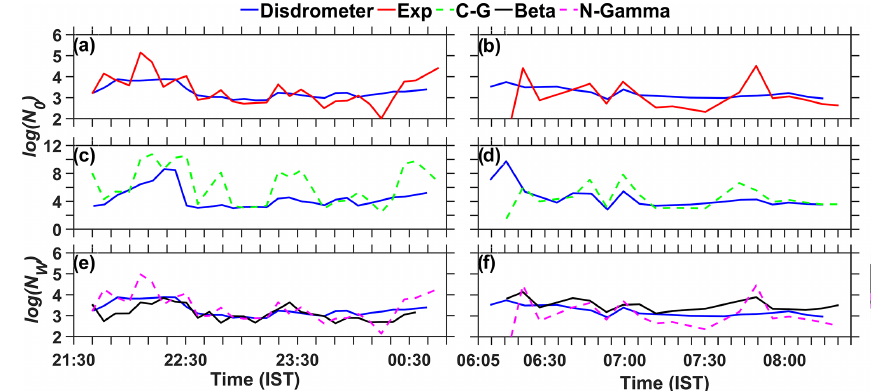
Figure 8. Comparison of log N 0 (a, b) by assuming an exponential distribution and (c, d) by assuming gamma distributions on 12 September 2019 and 15 November 2020, respectively, with a disdrometer-derived log N 0 . (e, f) Comparison of the log N W by N-Gamma and β methods with the disdrometer-derived log N W on the above days.